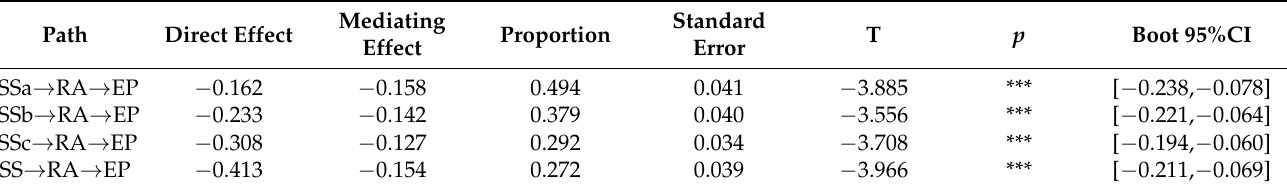
Table 4. Mediating effect (Bootstrap =